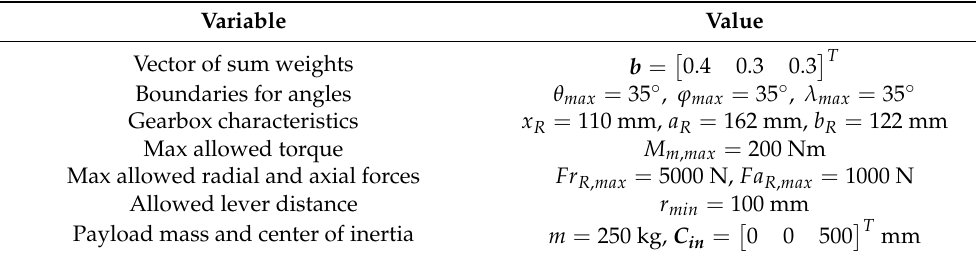
Table 3. Necessary optimization variables and their values.